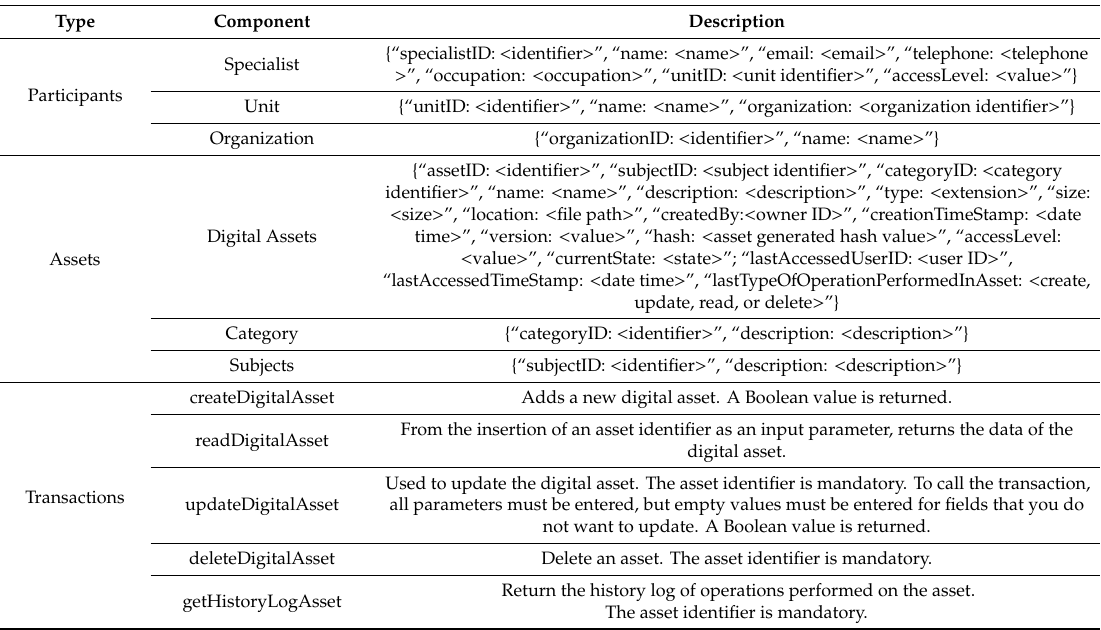
Table 8. Smart control